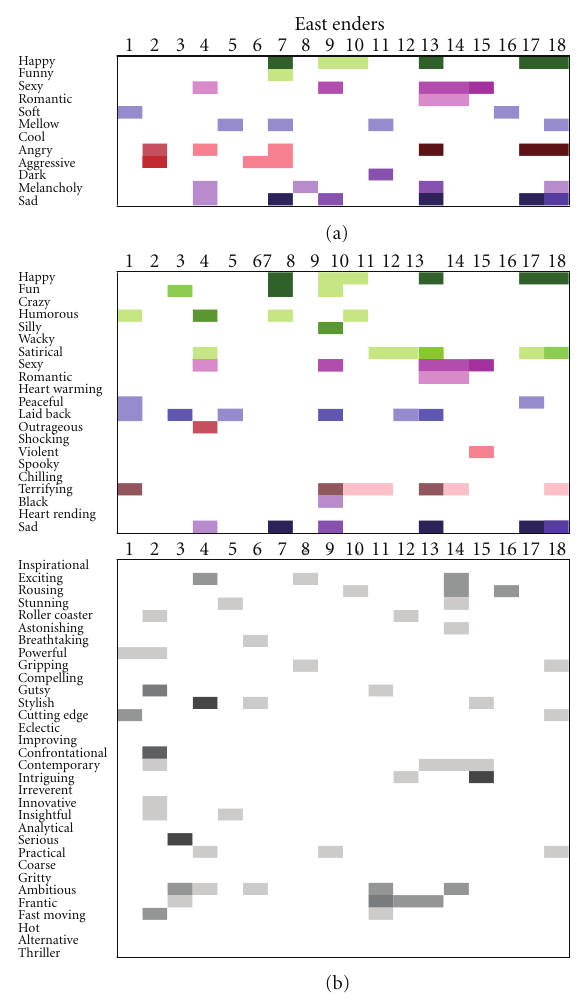
Figure 12: LSA correlation values of 18 episodes of (a) “East Enders” against 12 last.fm tags, and (b) 53 tva atmosphere